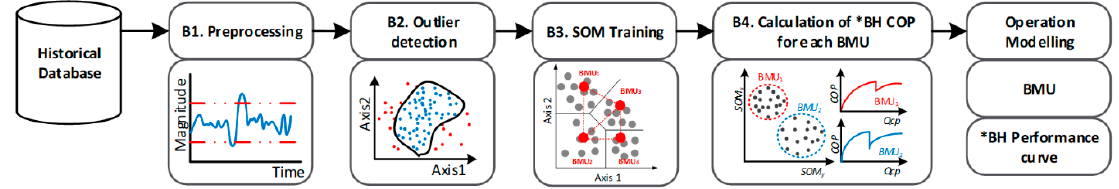
Figure 5. Process operation modelling. * BH stands for best historical performance.